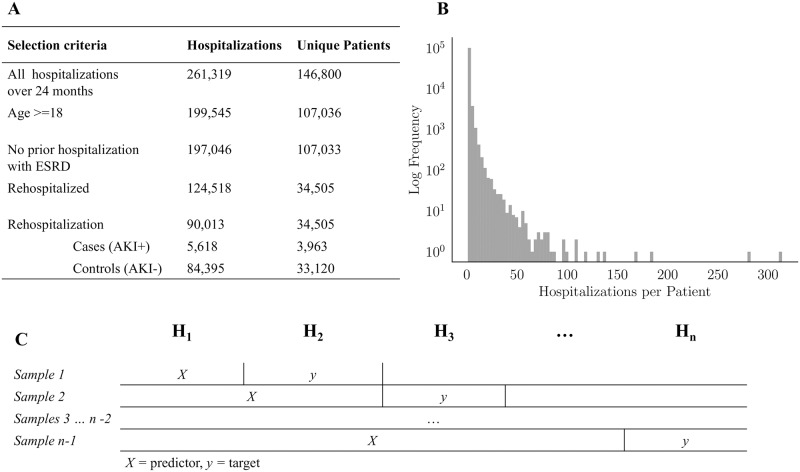
Cohort selection.On the top left, the selection procedure used to obtain the rehospitalization cohort is shown. On the top right, the distribution of the 197,046 hospitalizations not preceded by a diagnosis of ESRD is shown. On the bottom, a schematic of predictor/target generation is shown for an example patient with n hospitalizations from which n − 1 training cases were derived. For each target rehospitalization, y, data from all prior hospitalizations, X, are used as predictors. Multiple prior hospitalizations were aggregated using G as described above.